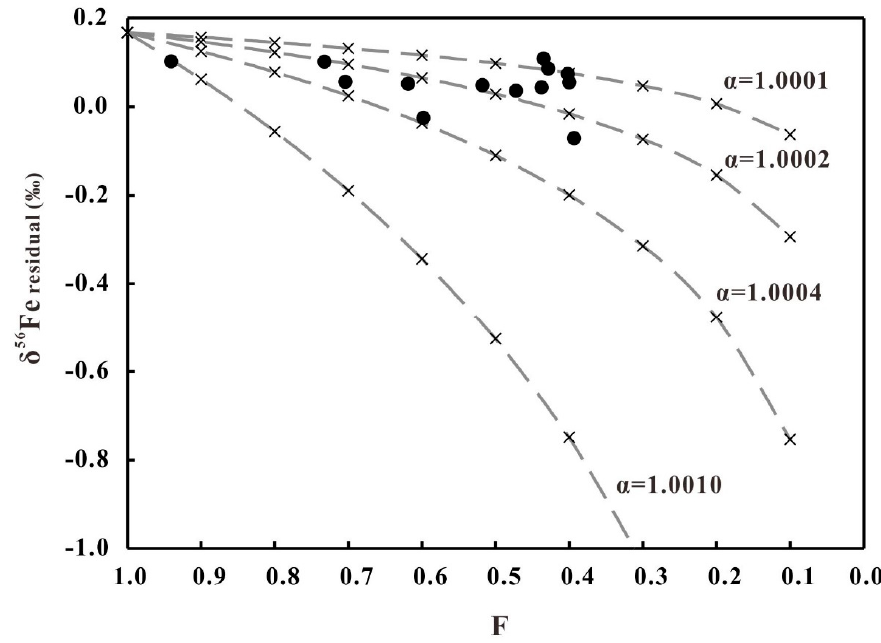
Figure 7. Rayleigh fractionation of Fe isotopes in diorites during hydrothermal alteration in the Han- Xing Fe skarn deposits. Han-Xing Fe skarn